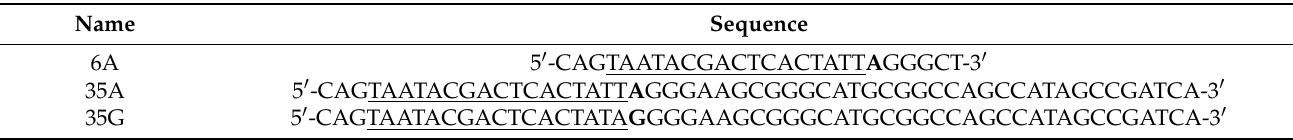
Table 1. Sequences of template DNA used for in vitro transcription. T7 promoter sequence is underlined, first transcribed base is in